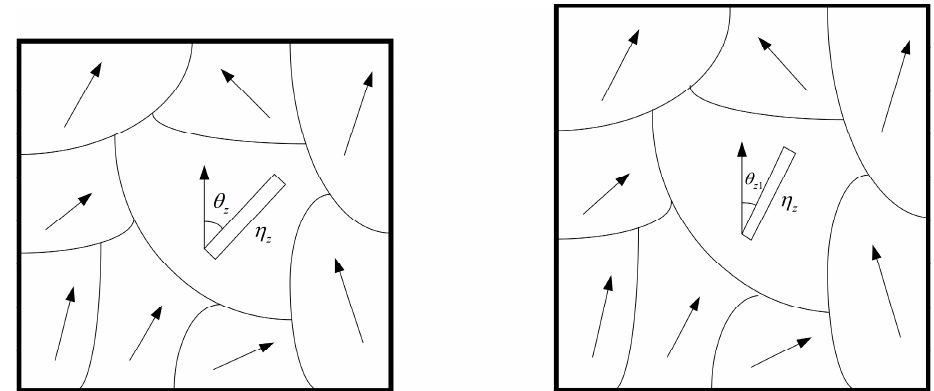
Figure 7. Schematic diagram of electric domain steering by electric field polarization.